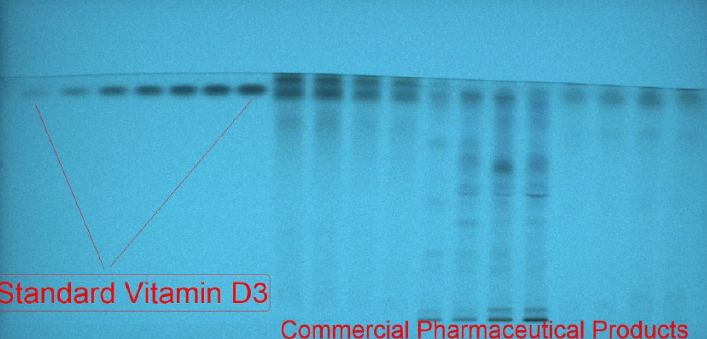
Figure 1. A typical thin-layer chromatography (TLC) plate of standard vitamin D3 (VD3) and commercial formulations developed using ethanol-water (70:30 v v − 1 ) as the greener mobile phase for the greener high-performance TLC (HPTLC) method.